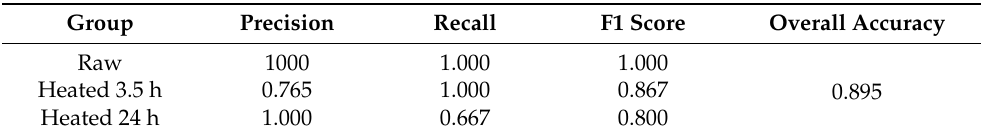
Table 4. Precision, recall, F1 score, and overall accuracy for raw and heated eucalyptus honey at 40 ◦ C for different heating